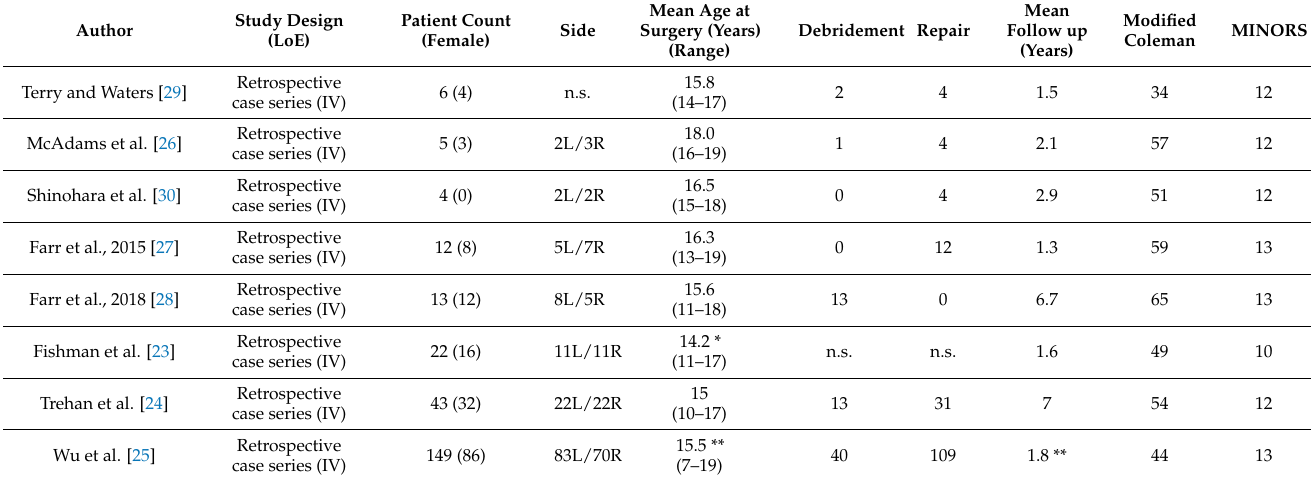
Table 1. Key aspects.